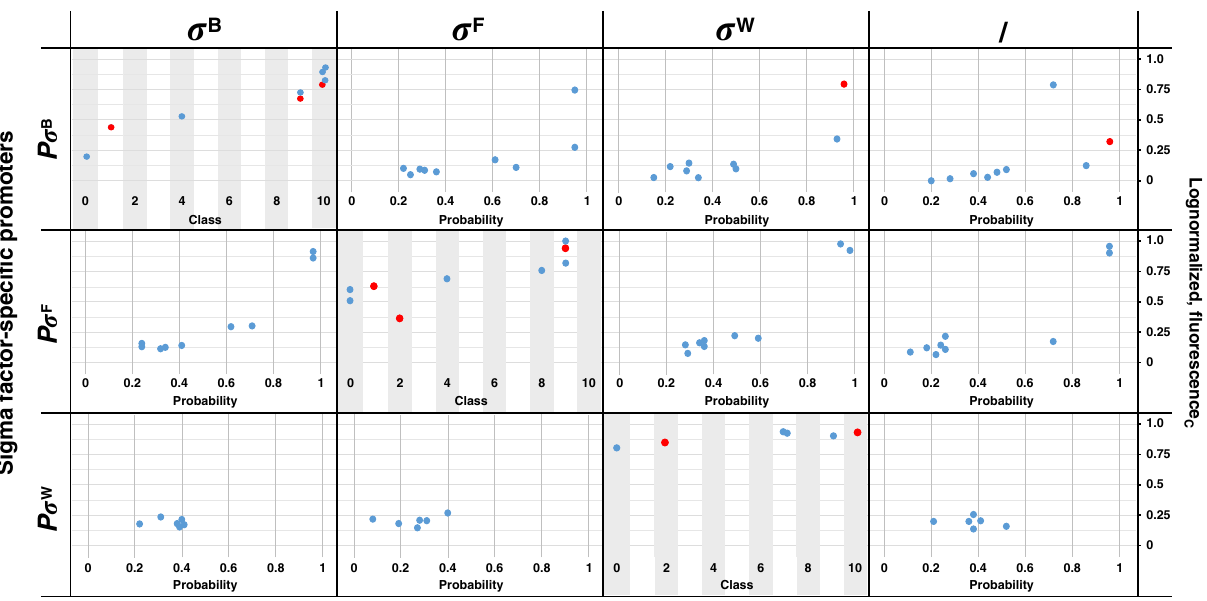
Fig. 6 Promoter transcription initiation frequency (TIF) of the de fi ned sets of promoters created and characterized in previous work 56 in relation to their predicted class and orthogonality. Values are corrected fl uorescence measurements ( fl uorescence C ), logarithmic transformed and normalized between 0 and 1. Promoters containing deviant spacer lengths were excluded. Higher probability values indicate a higher probability for loss of orthogonality. Data points in red indicate the speci fi c sequence was part of the training data set. Source data are provided as a Source Data fi